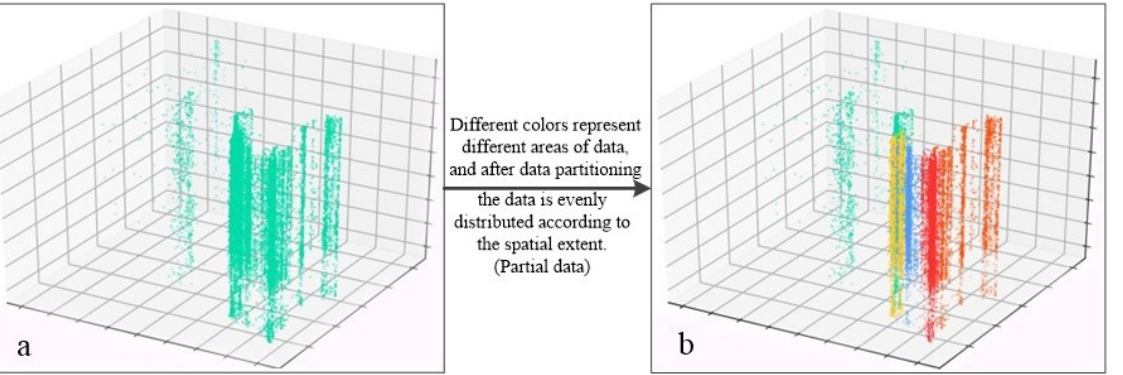
Figure 8. Multi-level spatio-temporal coding model based on Hilbert curve partitioning (partial data of the study area). ( a ) Data distribution without spatial data partition, ( b ) Data distribution for partitioning spatial data (Color represents partition).